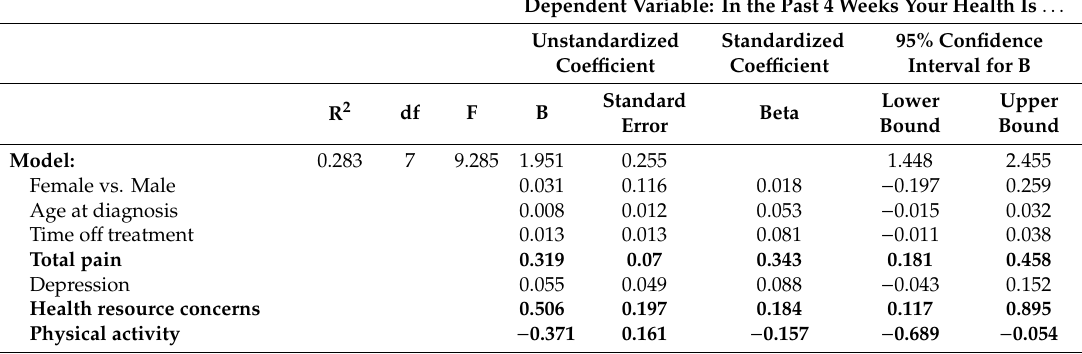
Table 5. Linear regression model for clinical variables, health problems and health behaviors associated with survivors of childhood